Question: Write a caption explaining this figure to a reader.
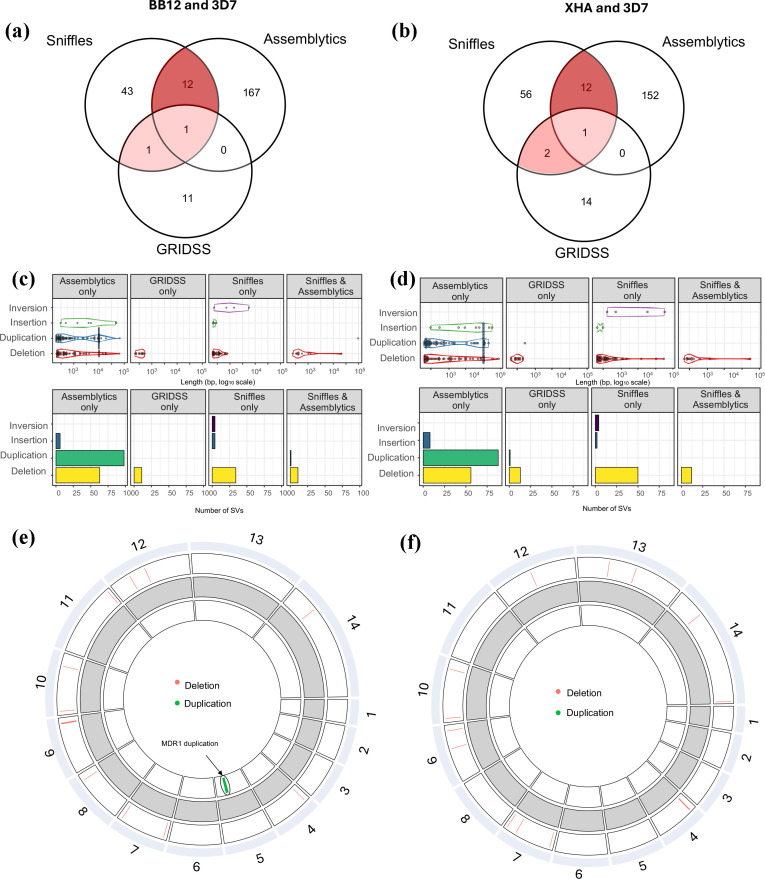
Answer: Comparison of SV calling pipelines using long reads only (Sniffles), short reads only (GRIDSS) and our de novo assemblies (Assemblytics). Overlaps in the sets of high-quality SVs identified by each pipeline, BB12 and XHA, are shown in ( a ) and ( b ), respectively, with red intensity indicating the number of overlaps. SVs identified by different pipelines are considered equivalent if they overlap by at least 1 bp, correspond to the same SV class and have similar lengths (i.e. the length of the shorter SV is at least 75% of that of the longer SV) (Text S8). Sniffles (which uses long reads only) and Assemblytics (which is informed by our de novo assemblies) show a reasonable number of concordances, while GRIDSS (which uses short reads only) exhibits very little concordance with either Sniffles or Assemblytics. SV types and lengths for BB12 and XHA are shown in ( c ) and ( d ), respectively. SV length and type distributions are generally quite similar for Sniffles and Assemblytics. For each panel, SVs are stratified into four categories: Assemblytics only, GRIDSS only, Sniffles only and SVs concordant between Sniffles and Assemblytics. Within each category, the upper violin plots show the distribution of SV lengths (x-axis: length in base pairs on a log₁₀ scale) for each SV type (deletion, duplication, insertion and inversion); the lower panel shows the total count of SVs (x-axis: number of SVs) for each SV type. SV length and type distributions are generally similar between Sniffles and Assemblytics. Genome-wide SV maps relative to 3D7 reference genome, restricted to SVs concordant across Sniffles and Assemblytics, are shown for isolates BB12 ( e ) and XHA ( f ), respectively. Both Sniffles and Assemblytics detected the known MDR1 duplication in BB12.